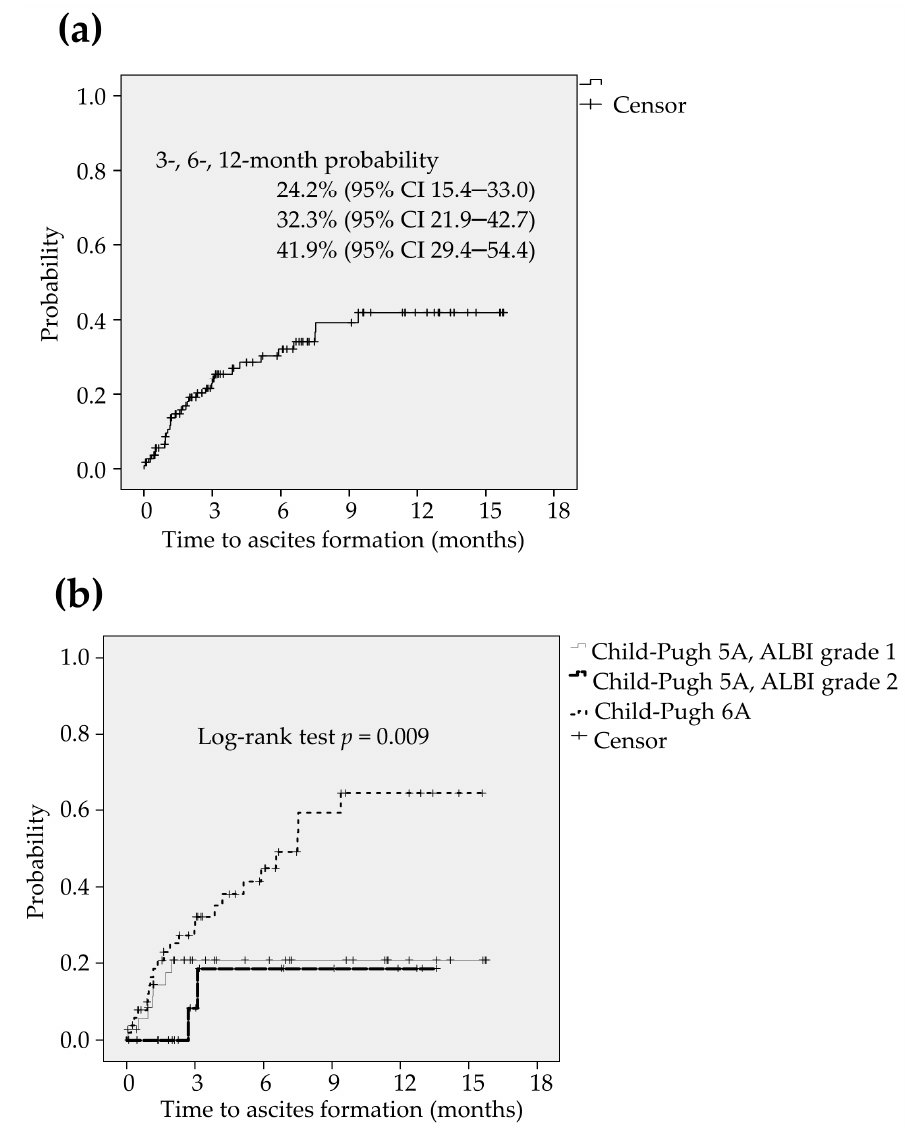
Figure 4. ( a ) The formation of ascites was found in 32 patients (28.6%) during the lenvatinib treatment. 15.4 − 33.0), 32.3% (95% CI 21.9 − 42.7) and 41.9% (95% CI 29.4 − 54.4), respectively. ( b ) The formation of CP5A-G2 ( p = 0.009). CI: confidence interval, CP5A-GI: Child-Pugh score 5 and ALBI grade 1,